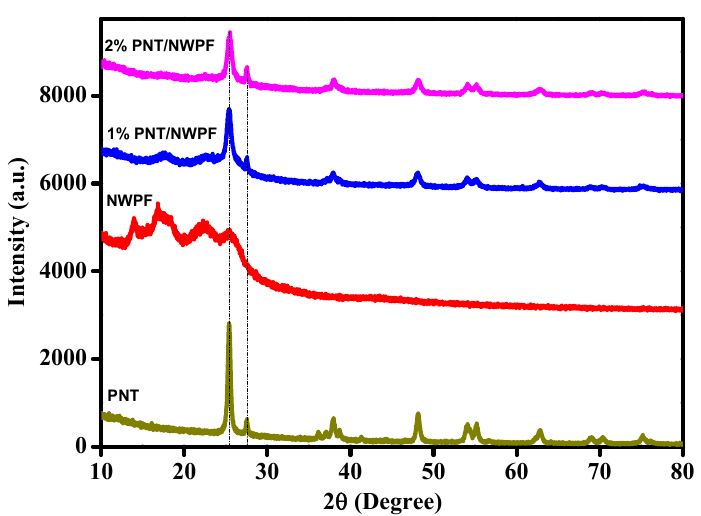
Figure 3. XRD pattern of PNT/NWPF.